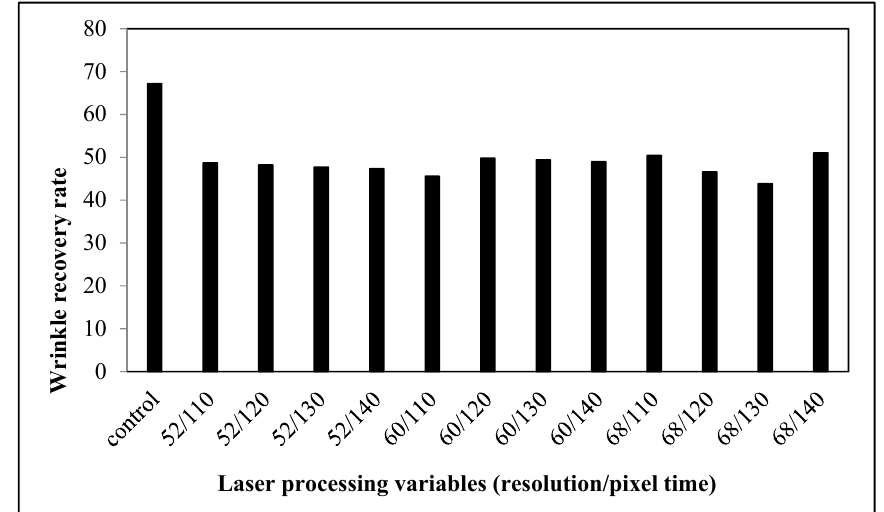
Figure 11. Relationship between laser processing variables and the wrinkle recovery rate of cotton/polyester blended fabric.